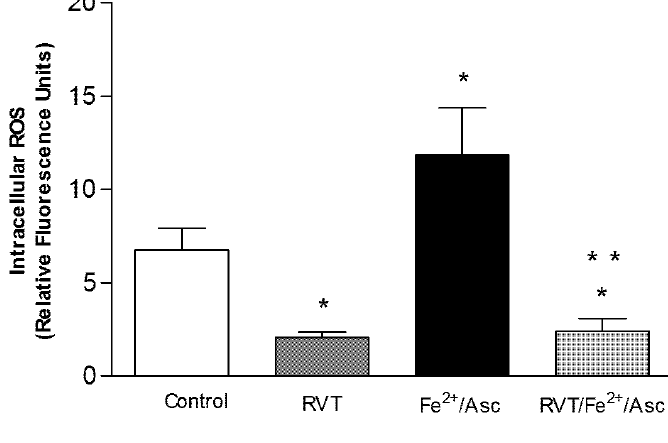
Figure 2. Effect of RVT treatment on intracellular ROS levels. Spermatozoa were obtained from ductus deferens in M-16 medium, pooled and incubated with RVT, Fe 2+ /asc or RVT + Fe 2+ /asc. ROS levels were evaluated using the CM-H was measured in a spectrofluorometer. Values represent the mean ± SD of three independent experiments performed in duplicate. * p < 0.001 vs. control group. ** p < 0.001 vs. Fe 2+ /asc